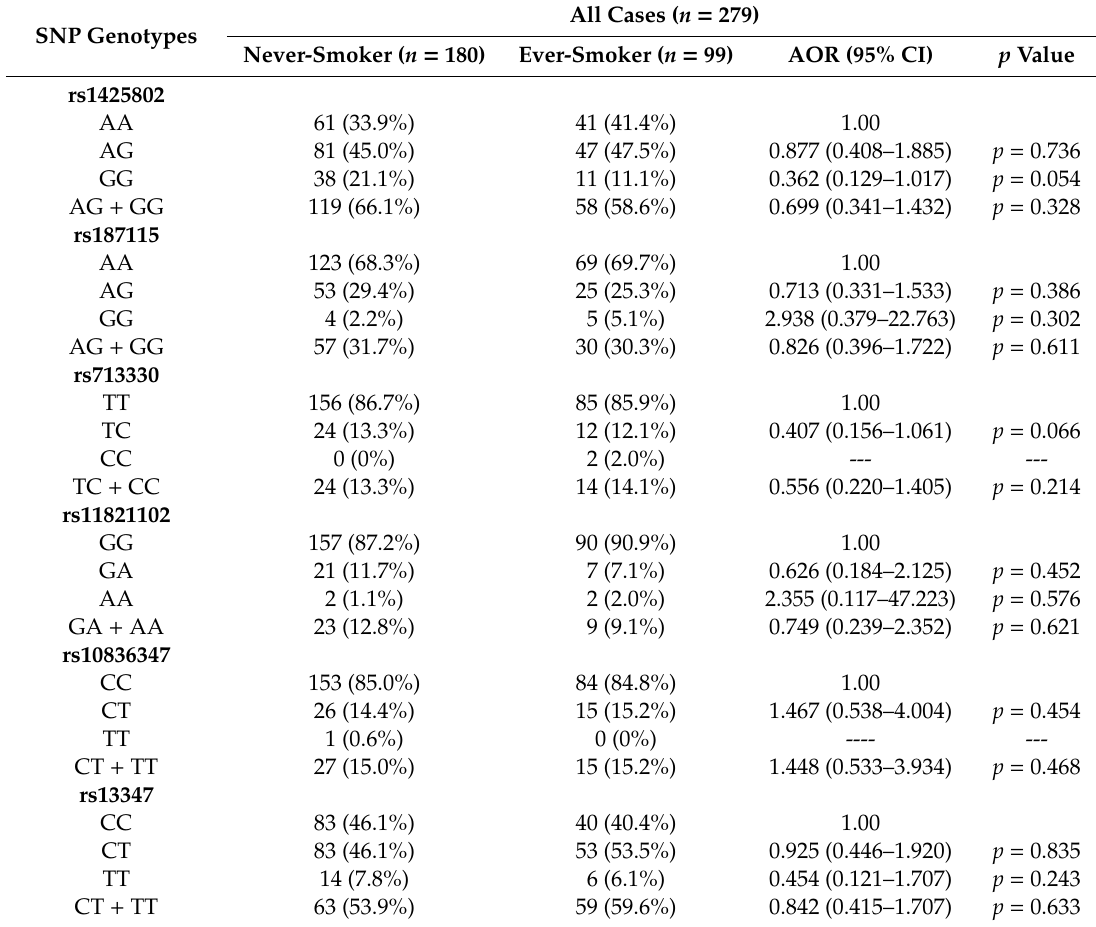
Table A2. The associations between the polymorphisms of CD44 and the cigarette smoking status in lung adenocarcinoma.